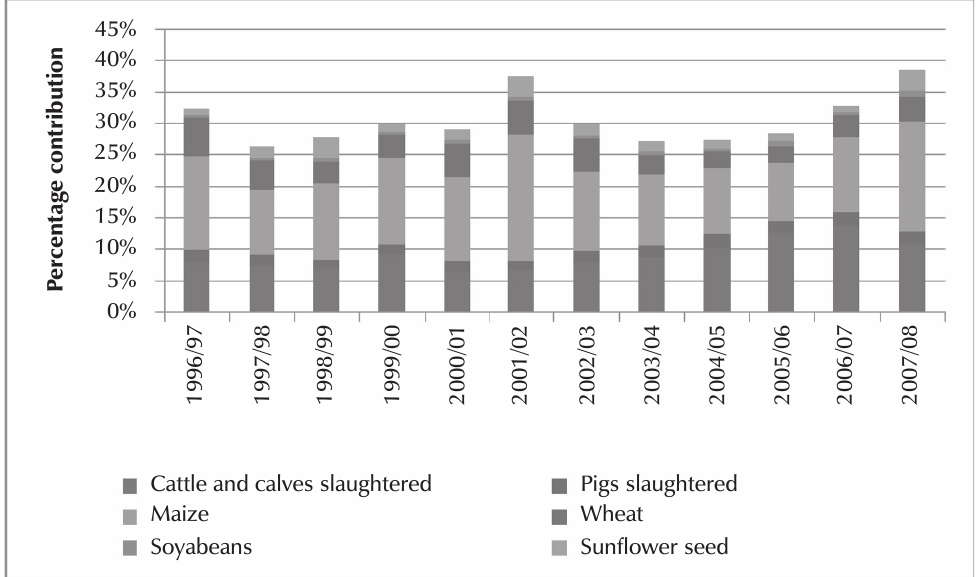
The contribution of selected agricultural products to the gross value of agricultural production